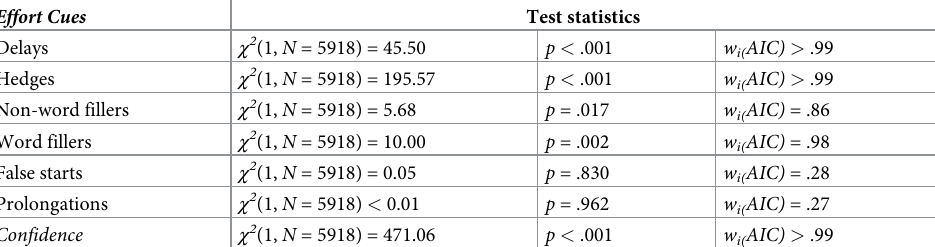
Table 1. Results of model comparisons assessing the effects of each retrieval-effort cue and confidence on memory accuracy. Effort